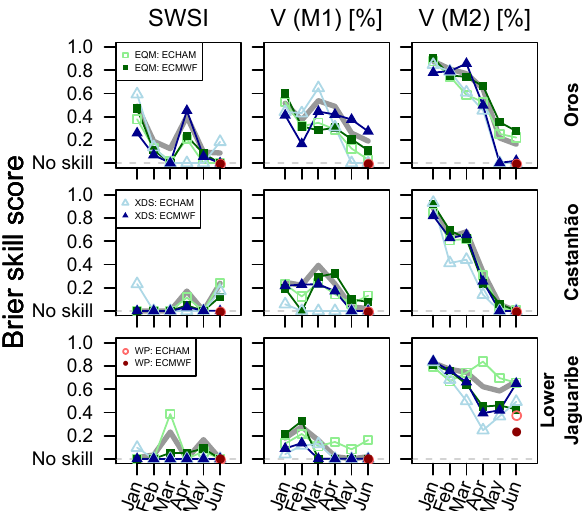
Figure 11. BSS of the forecast of drought events as defined by SWSI, V predicted with M1 and V predicted with M2 (based on month-to-month variation). An event is defined when an index is lower than the 30th percentile of the observations. The fore- cast period is January to June. Three regions are presented: lower Jaguaribe, Orós and